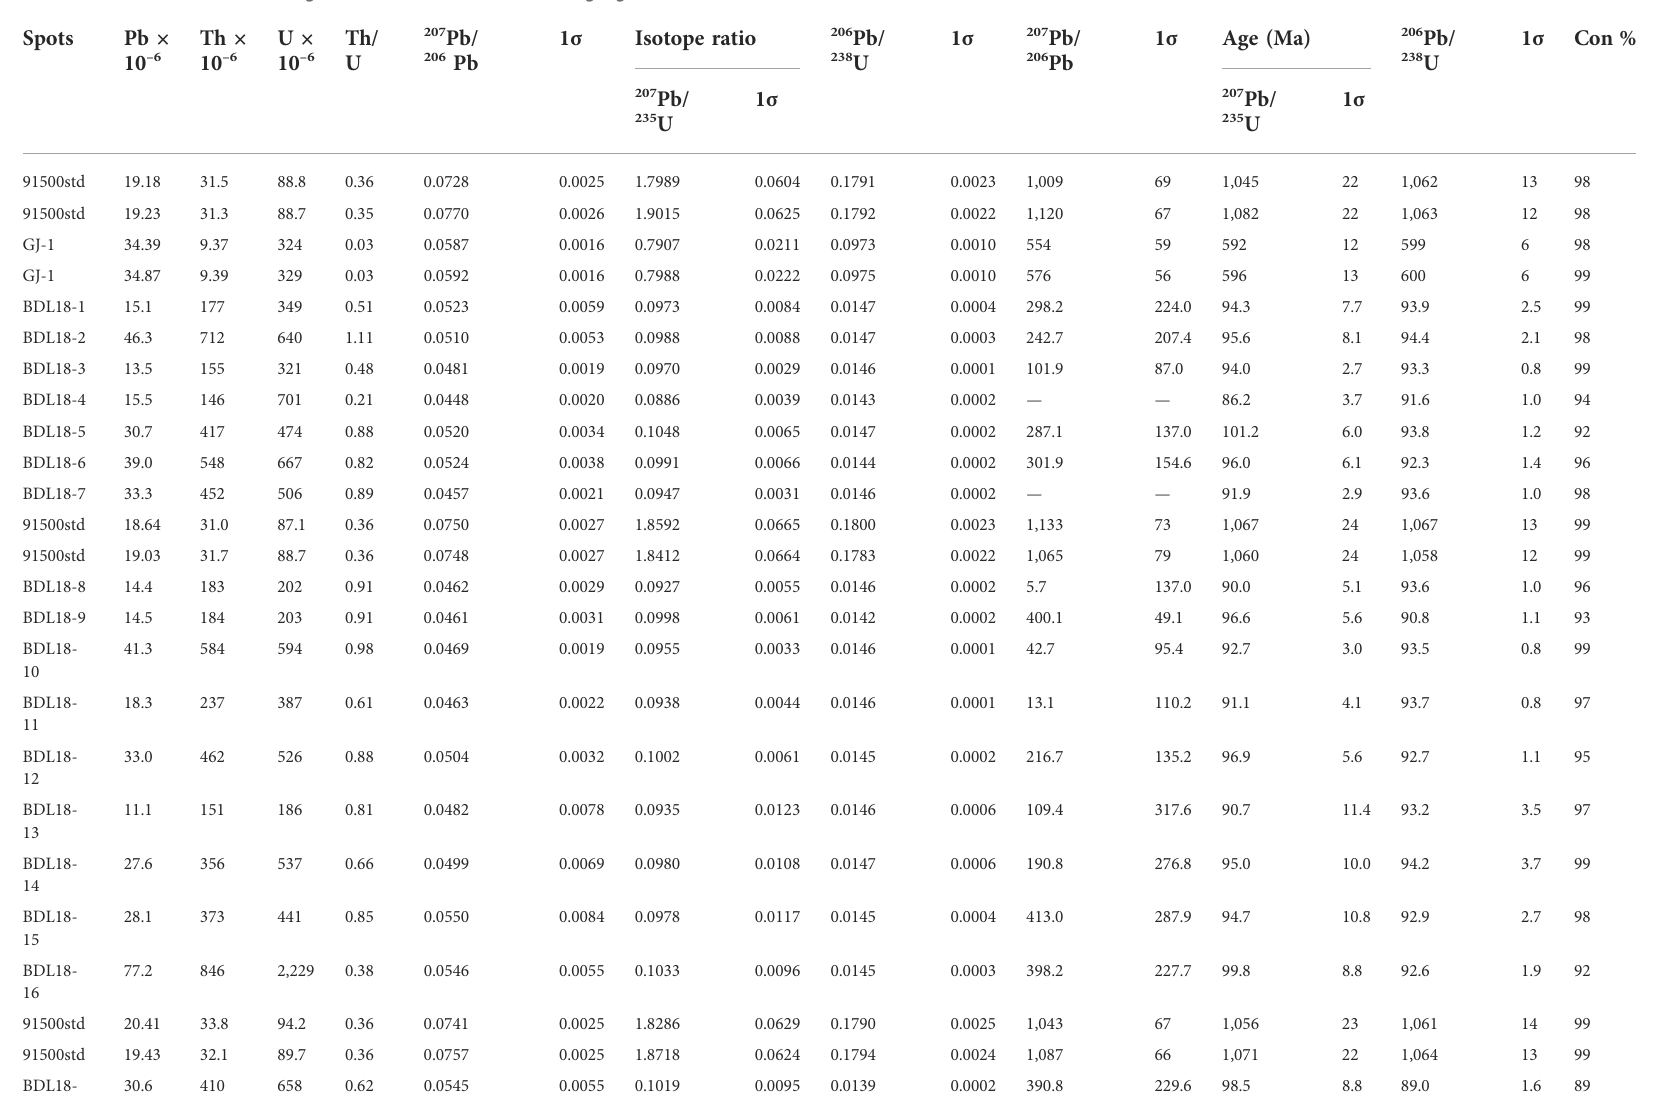
TABLE 2 LA-ICP-MS zircon U-Pb ages of monzodiorite in the Budongla gold district.